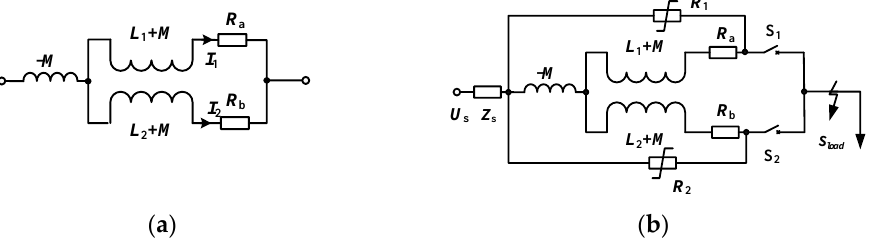
Figure 1. The equivalent circuit of the quenched FC-SFCL. ( a ) The equivalent circuit of the parallel inductance; ( b ) equivalent circuit of the FC-SFCL.